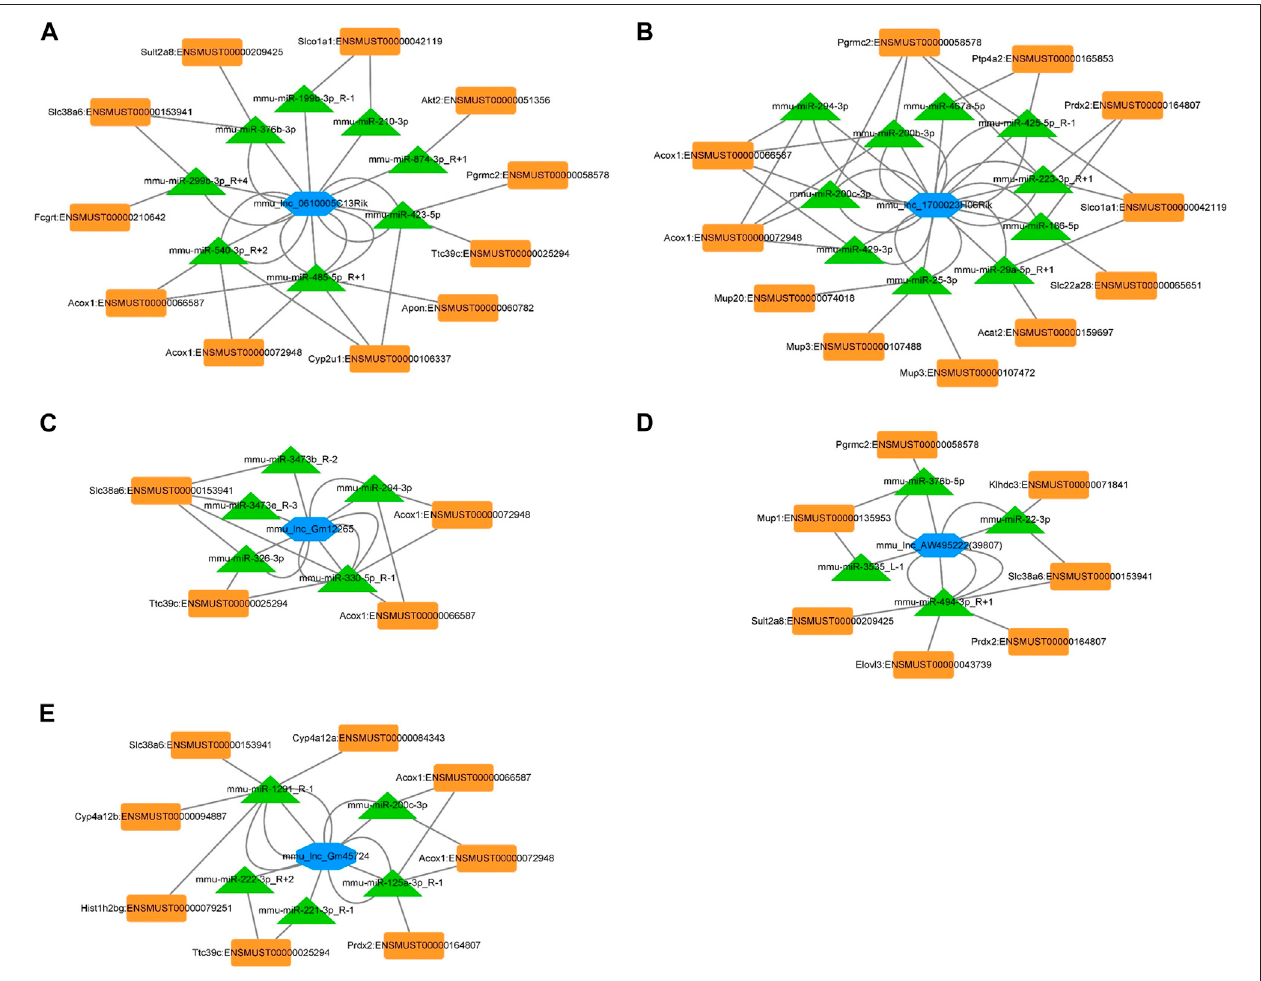
FIGURE 5 | ceRNA networks of mou_lnc_0610005C13Rik, mou_lnc_1700023H06Rik, mou _ lnc _ Gm12265, mou _ lnc _ AW495222(39,807), and mou_lnc_Gm45724. Blue hexagon represents the fi ve lncRNAs. The green triangles and orange quadrilaterals represent differentially expressed miRNA and mRNA,